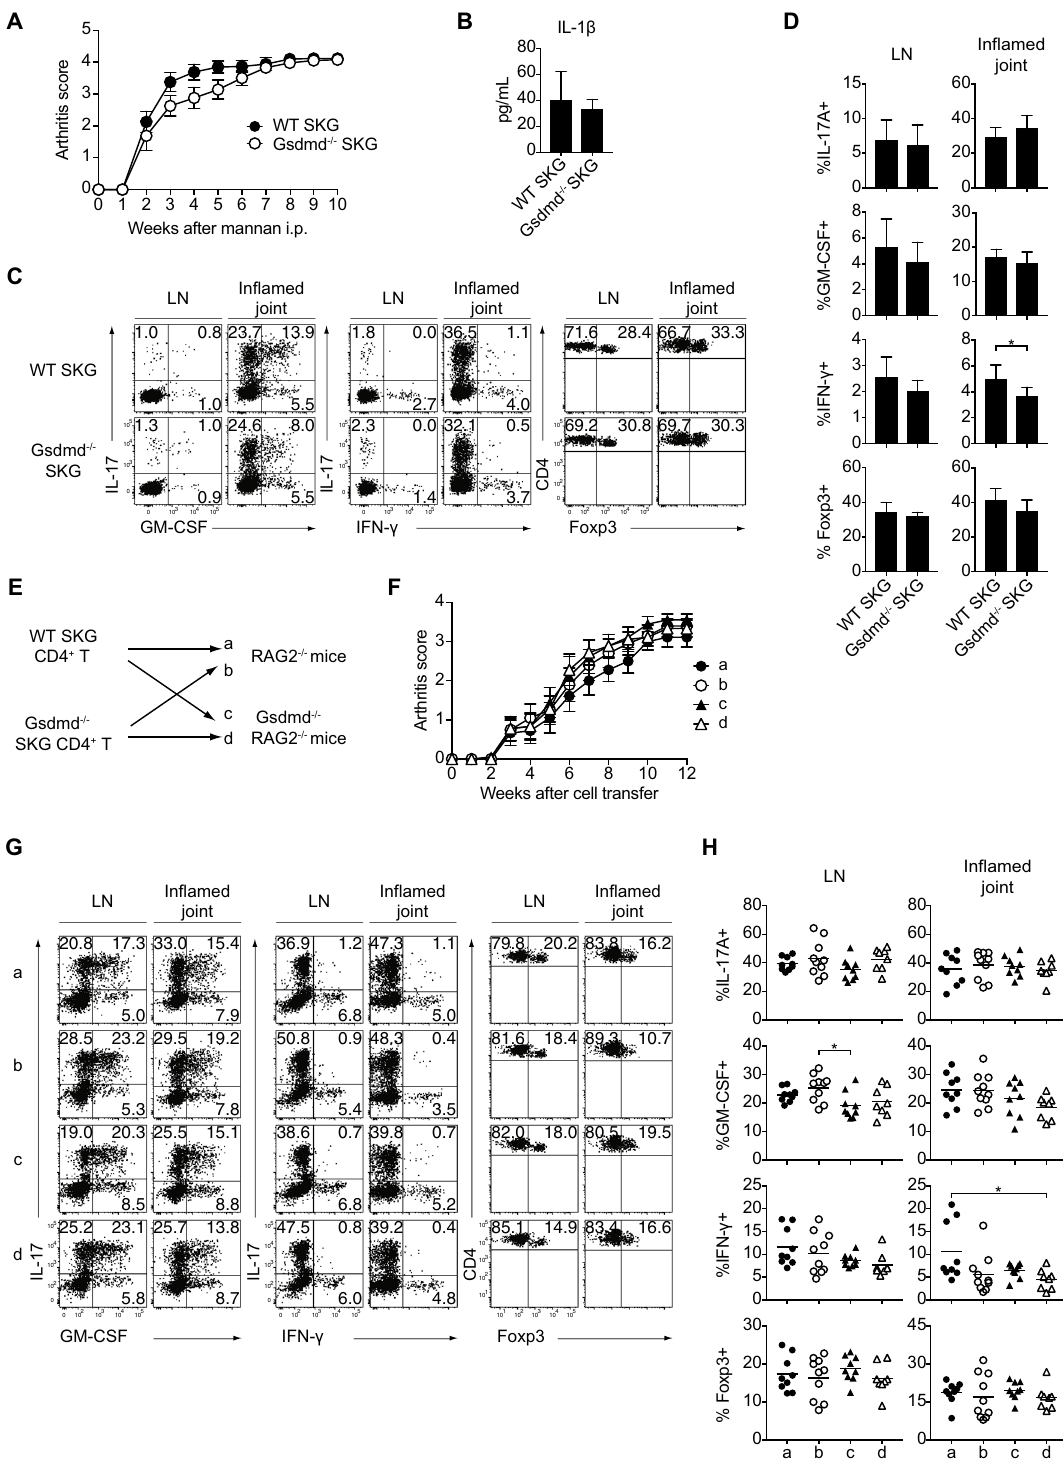
Figure 2. The dispensable role of Gsdmd in the development of autoimmune arthritis. ( A ) The arthritis scores of WT and Gsdmd −/− SKG mice (n = 8 each) after the injection of mannan (20 mg). ( B ) The IL-1β concentration of synovial tissues from inflamed joints. (C,D) Flow cytometry of IL-17A + , GM-CSF + , IFN-γ + and Foxp3 + cells in CD4 + T cells in draining LNs and inflamed joints of WT and Gsdmd −/− SKG mice at 10 weeks after mannan injection (n = 8 each). ( E ) Experimental design of adoptive transfer of CD4 + T cells from WT or Gsdmd −/− SKG mice into Rag2 −/− or Gsdmd −/− Rag2 −/− mice. ( F ) The arthritis scores of the four groups (a-d) shown in ( E ) (n = 9–10 each). ( G , H ) Flow cytometry of IL-17A + , GM-CSF + , IFN-γ + and Foxp3 + cells in CD4 + T cells in draining LNs and inflamed joints of the four groups of mice at 12 weeks after cell transfer (n = 8–10 each). The vertical bars denote the SD in panels ( B , D ) and SEM in ( A , F ). The horizontal line in panel ( H) denotes the mean. * P < 0.05. Data are pooled from two independent experiments in panels (A,B,D,F,H)